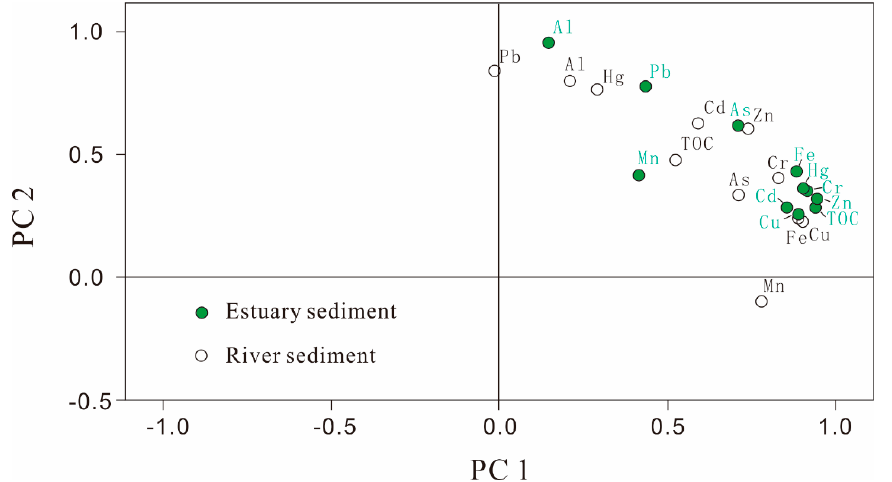
Figure 5. Principal component loading plot of the heavy metals and metalloids in the river and estuary sediments.